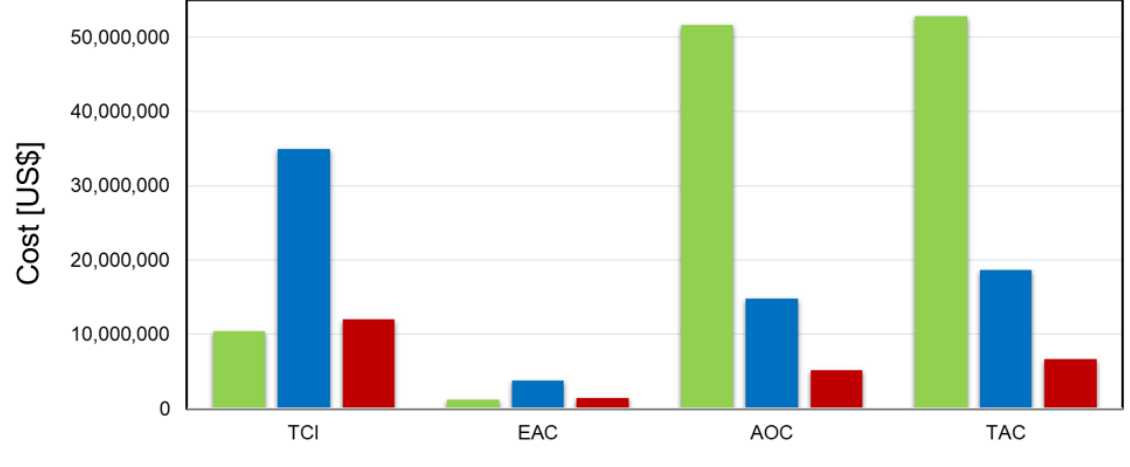
Figure 4. Calculated TCI, EAC, AOC, and TAC of each